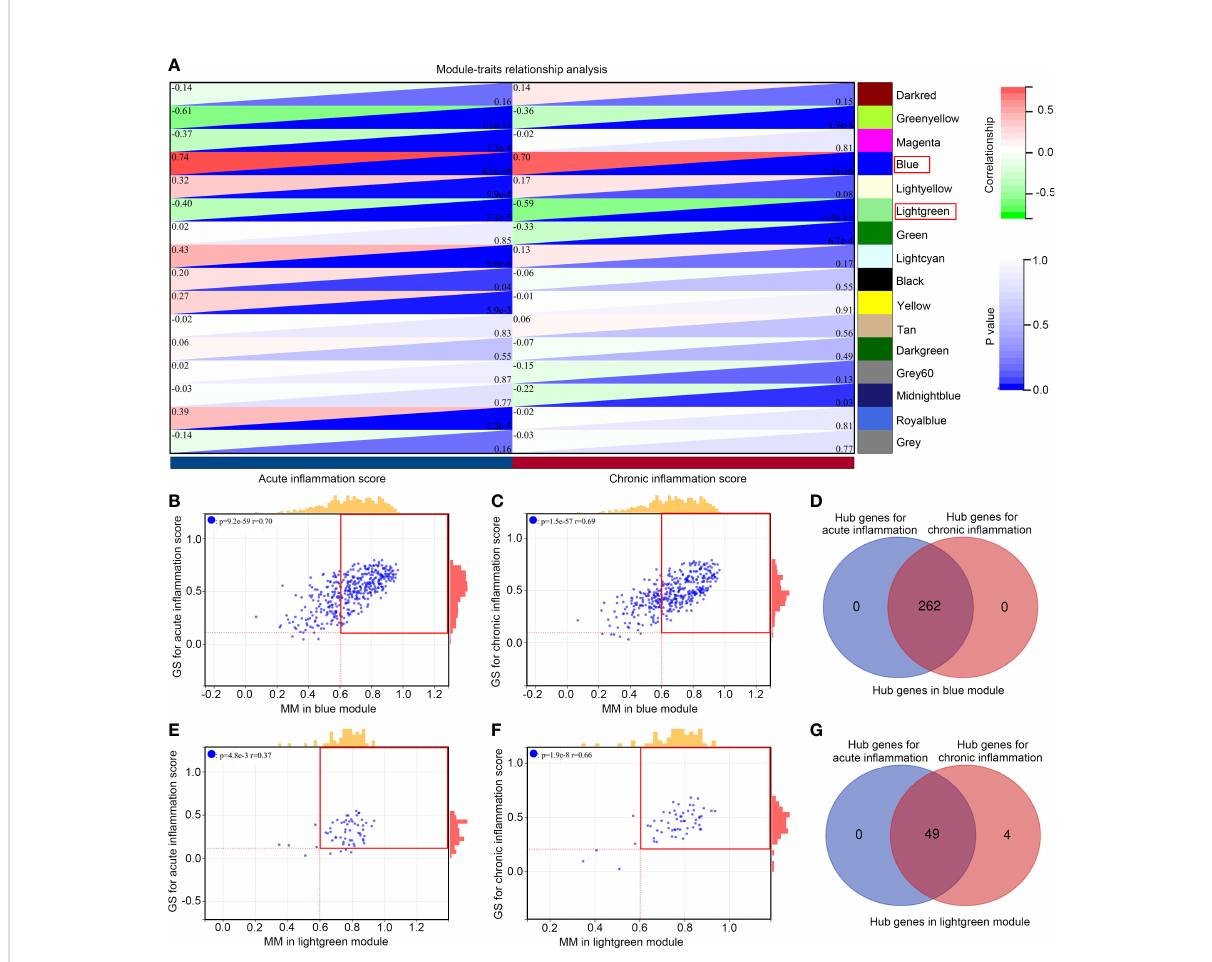
FIGURE 3 Module relationships with clinical traits (A) Identi fi cation of signi fi cant modules associated with clinical traits; the genes of the blue and light green modules were signi fi cantly correlated with acute and chronic in fl ammation scores; the relationship between gene signi fi cance (GS) and module membership (MM) in the blue (B, C) and light green modules (E, F) ; Venn diagram of the hub gene intersection analysis between acute and chronic in fl ammation in patients with IS of the blue (D) and light green modules (G)